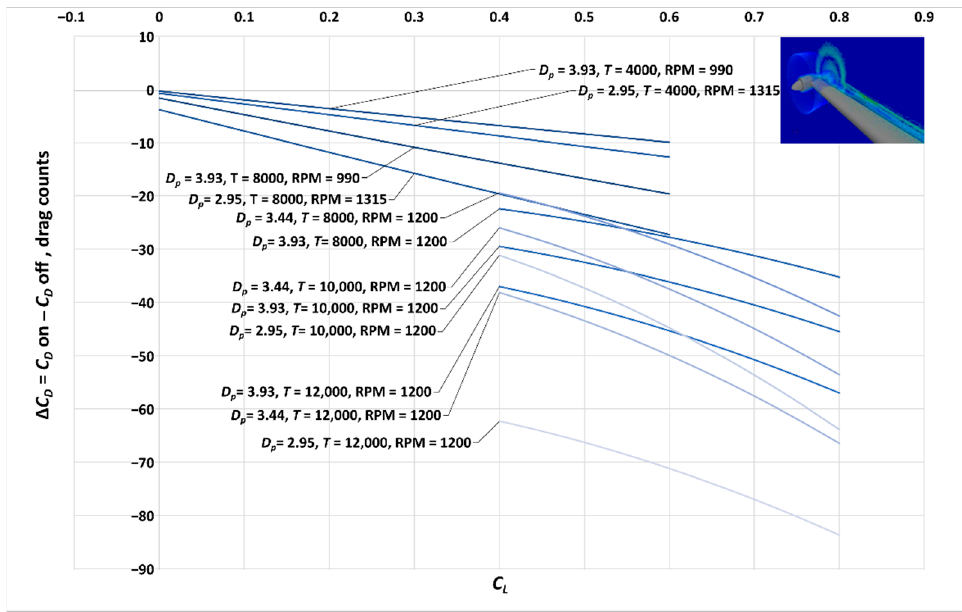
Figure 22. Wing drag improvement due to the propeller tip-mounted on an AR = 11 wing, M = 0.48, Re = 15 × 10 6 , thrust T in Newton. Analyses were also performed to evaluate the effect of rotation direction of each pro- peller, highlighting how co-rotating propellers were better than counterrotating propellers, as explained in Ref. [79]. Moreover, in 2016, NASA prepared and tested a DEP high-lift propeller testbed, highlighting a good agreement between numerical and experimental data [80]. The max lift was about doubled with respect to the unblown solution, increasing from about C L = 2.8 up to C L =